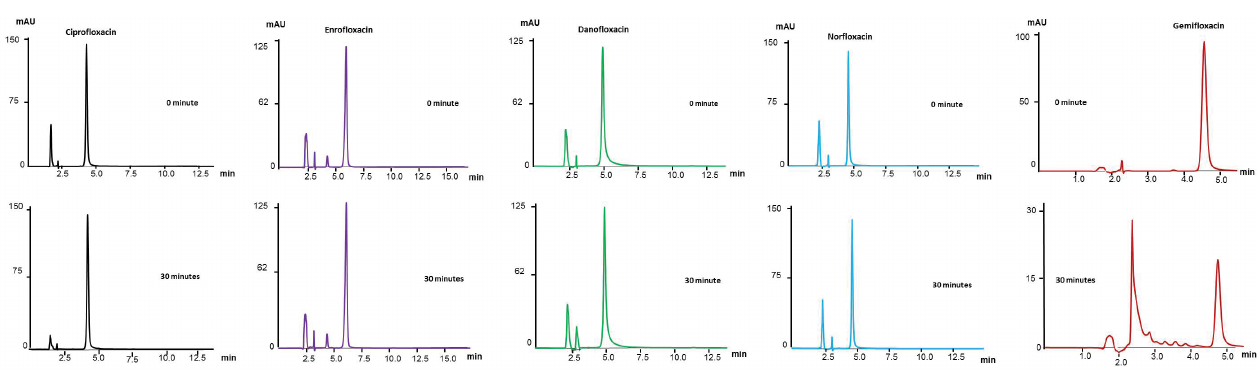
FIGURE 3 - Chromatograms of fluoroquinolones after treatment in photolytic conditions at time of 0 and 30 minutes. Chromatographic conditions describing in Table